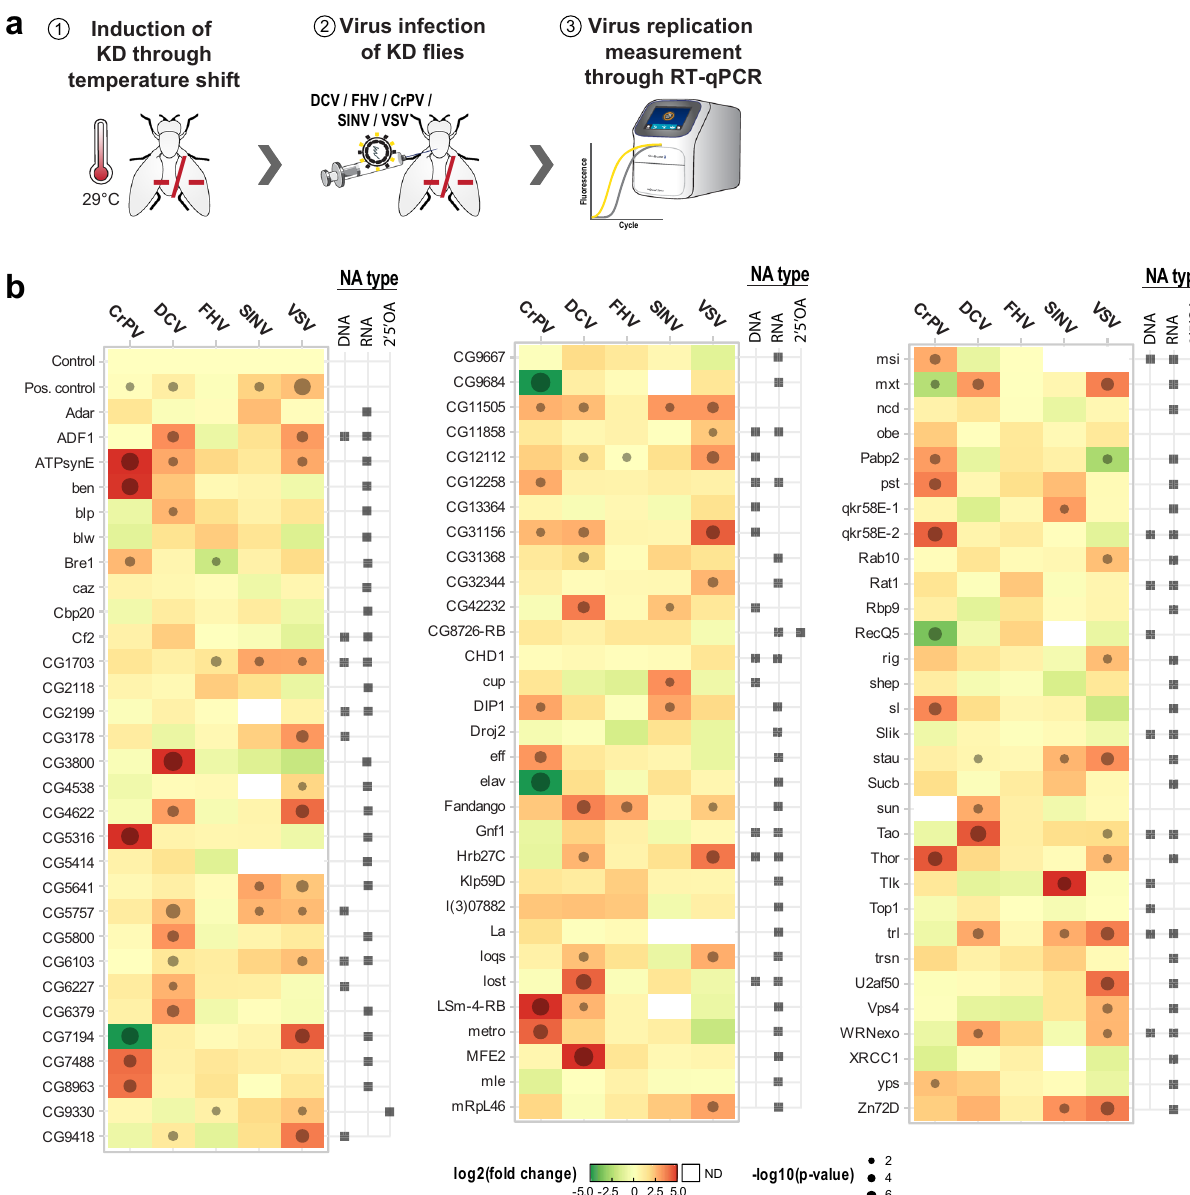
Fig. 4 RNAi knockdown and virus replication in fl ies. a Experimental procedure to test antiviral activity of candidate proteins in fl ies. The fl y Gal4/ Gal80 TS system allows for the temperature-sensitive expression of sh or inverted repeat RNA. Flies carrying both the Gal4/Gal80 and UAS-siRNA were moved to 29 °C, activating Gal4 and inducing the siRNA KD. Upon con fi rming the viability of the KD fl ies, they were individually infected via injection of DCV (500 pfu/ fl y), FHV (500 pfu/ fl y), CrPV (5 pfu/ fl y), SINV (2,500 pfu/ fl y), and VSV (10,000 pfu/ fl y). Viral replication was measured by RT-qPCR at 2 (CrPV, DCV, FHV) or 3 (SINV, VSV) days post-infection. b Heatmap showing fold change of virus gene expression normalized to the housekeeping gene RP49 upon target protein KD as compared to mCherry KD fl ies. Data represents the mean of biological triplicates. Signi fi cance was calculated using lsmeans R package (least-squares means, linear model) with Dunnet ’ s adjustment for p values for multiple hypothesis testing. Candidates were further categorized into DNA, RNA, and/or 2 ′ 5 ′ OA interacting proteins according to the results of the NA-AP-MS screen. Source data are provided as a Source Data fi RNAi lines, 64 showed a signi fi cant change in viral load. Depletion of three host factors consistently reduced virus growth and 57 proteins served as restriction factors that upon depletion led to increased virus replication levels independent of the virus tested. Four candidate proteins were pro- or antiviral in a virus-dependent manner. The data allowed us to draw parallels between the NA association speci fi city and the viral replication phenotype of spe- ci fi c proteins. For example, qkr58E-1, which was identi fi ed as a poly(I:C) and poly(A:U) interactor had an antiviral phenotype in SINV, a virus known for producing large quantities of dsRNA.